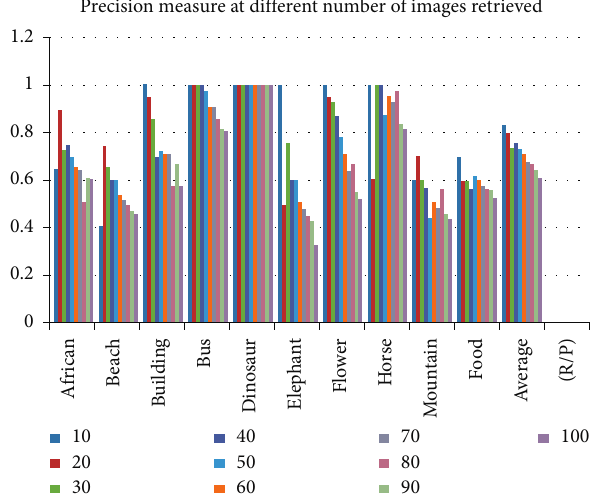
Figure 10: Precision is calculated for the number of images retrieved at Corel 1k.